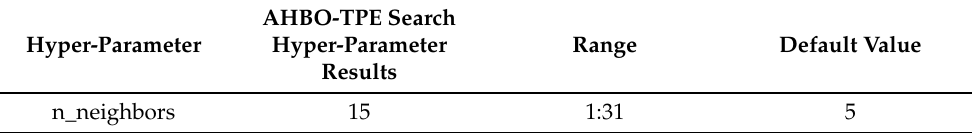
Table 12. KNN Model AHBO-TPE Search Hyper-parameter Results (Ember Dataset).